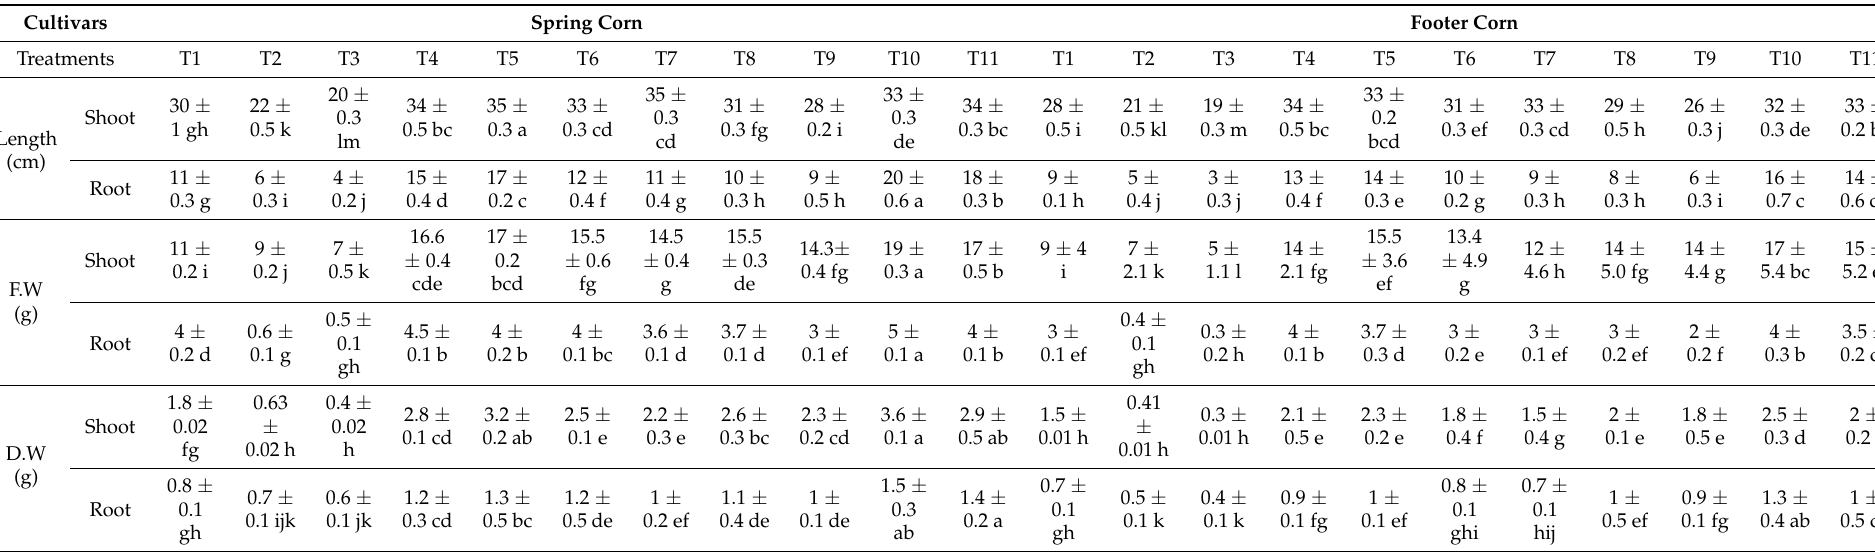
Table 1. Growth parameters of two maize cultivars were determined under different treatments against copper and nickel stress.